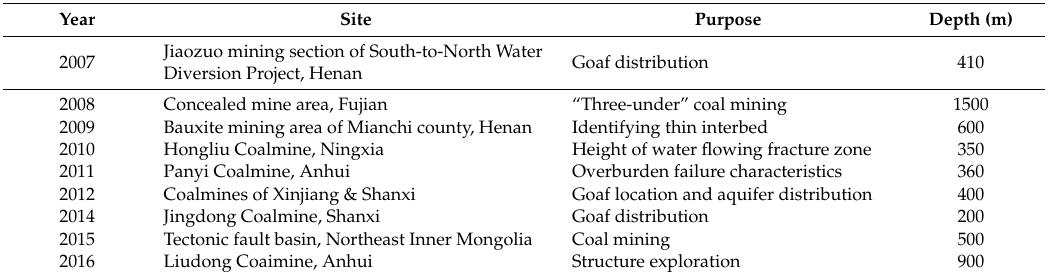
Table 1. Examples with magnetotelluric (MT) detection technique in mines.